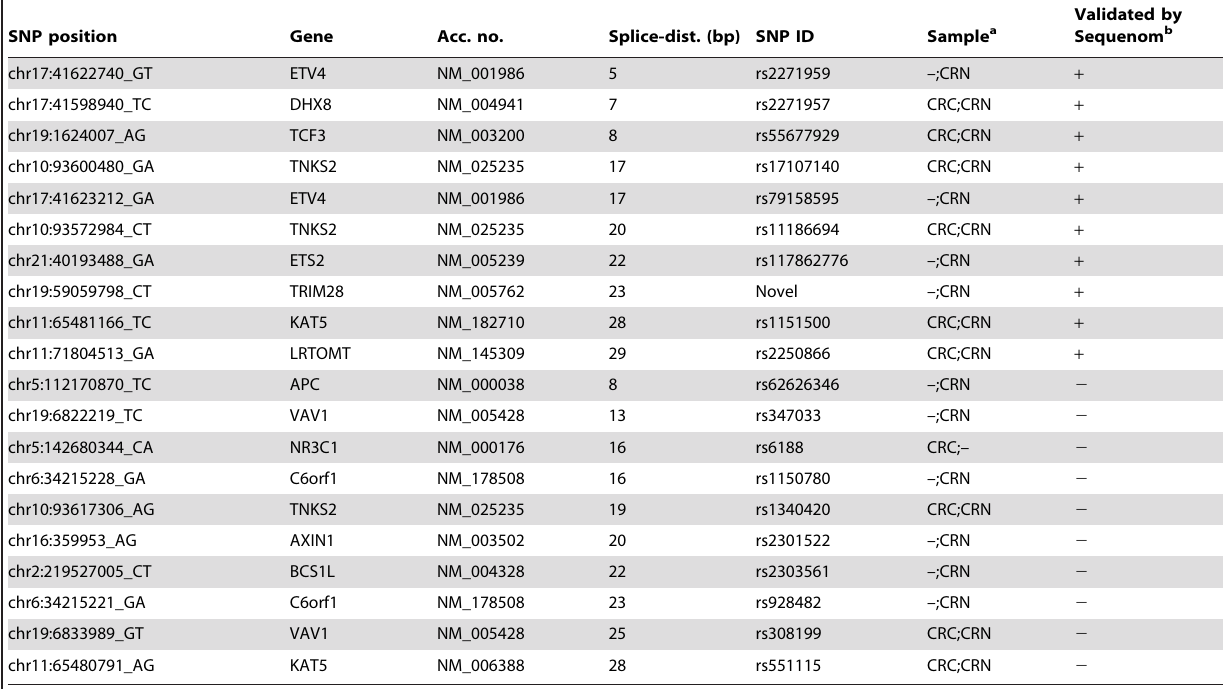
Validated by Sequenom b